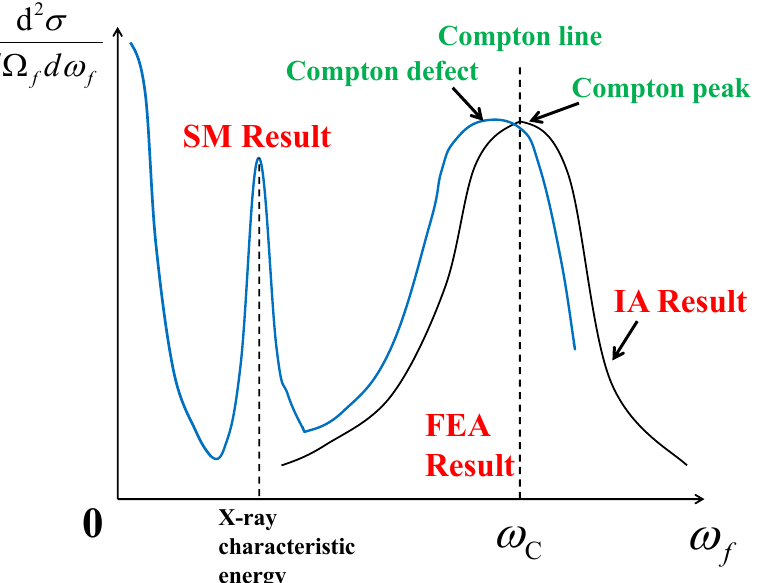
Figure 3. Schematic plot of Compton scattering DDCS in the SM approach at the scattering angle θ . The horizontal axis labels the finial photon energy ω f , and the vertical axis labels the DDCS of Compton scattering